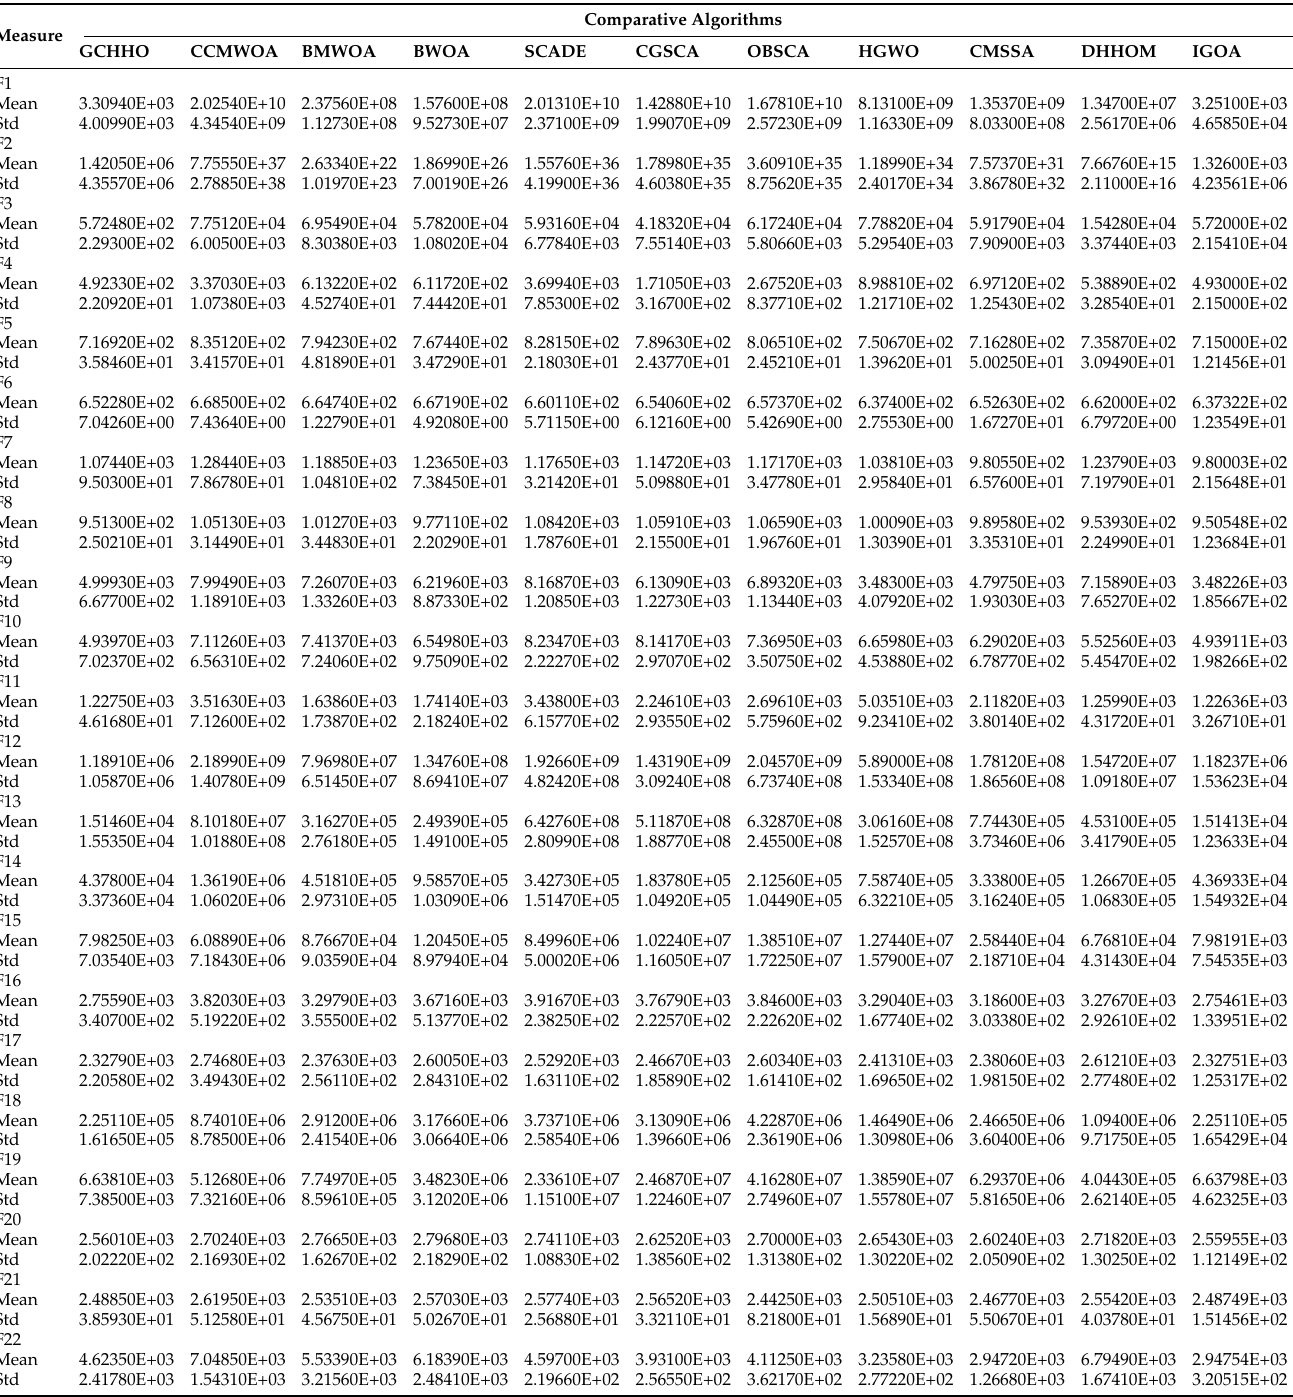
Table 10. The results of the proposed IGOA and other comparative methods using 30 CEC2017 benchmark